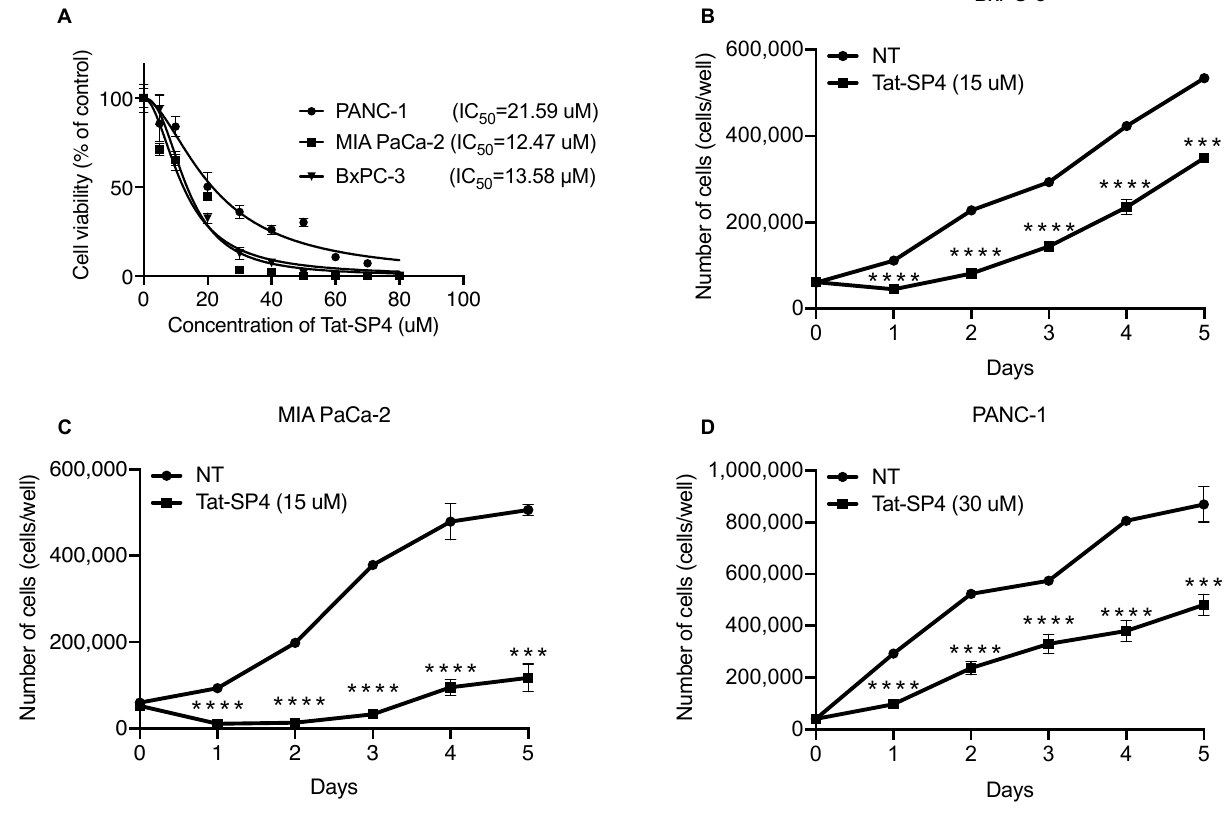
Figure 3. Tat-SP4 exerts potent anti-proliferative effect on PDAC cell lines. ( A ) Trypan blue exclusion assay to assess the cytotoxicity IC 50 of the indicated peptides in PDAC cells. Cells were treated with various concentrations of the indicated peptides for 24 h. Cell numbers were manually counted by the trypan blue dye exclusion method using a hemocytometer. Data are presented as mean ± SD from three independent experiments. ( B – D ) Cell proliferation assay was performed over a time span of five days in PDAC cells after treatment with the indicated peptides. Cells were treated with the indicated peptides at day 0, and the cell number was calculated at the given time points (NT: no-treatment). The assay was performed in 24-well plates with three independent measurements. Data are presented as mean ± SEM from three independent experiments; *** p < 0.001, **** p <